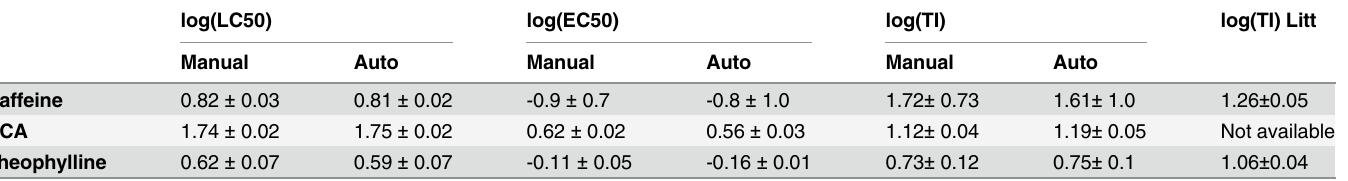
Table 7. Comparison of the deduced LC50, EC50 and TI for caffeine, DCA and